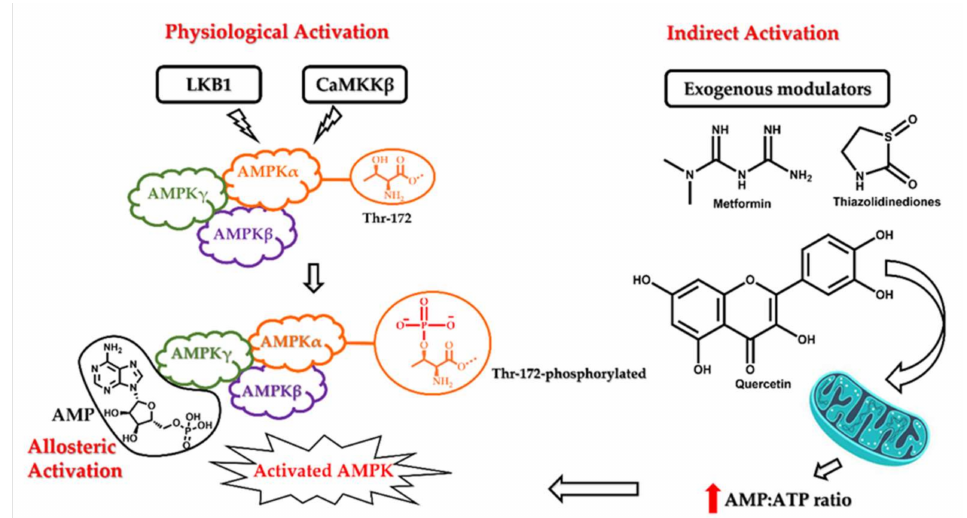
Figure 2. Mechanism of AMPK activation. AMPK can be activated via the LKB1 or CaMKK β pathway (physiological activation) following phosphorylation at threonine 172 residue in the α subunit. It can also be activated exogenously by drugs such as quercetin and metformin that act on the mitochondria and increase the AMP:ATP ratio, which subsequently activates the LKB1-mediated phosphorylation and activation of AMPK. Lastly, it can also be activated allosterically by the binding of AMP at the AMPK γ